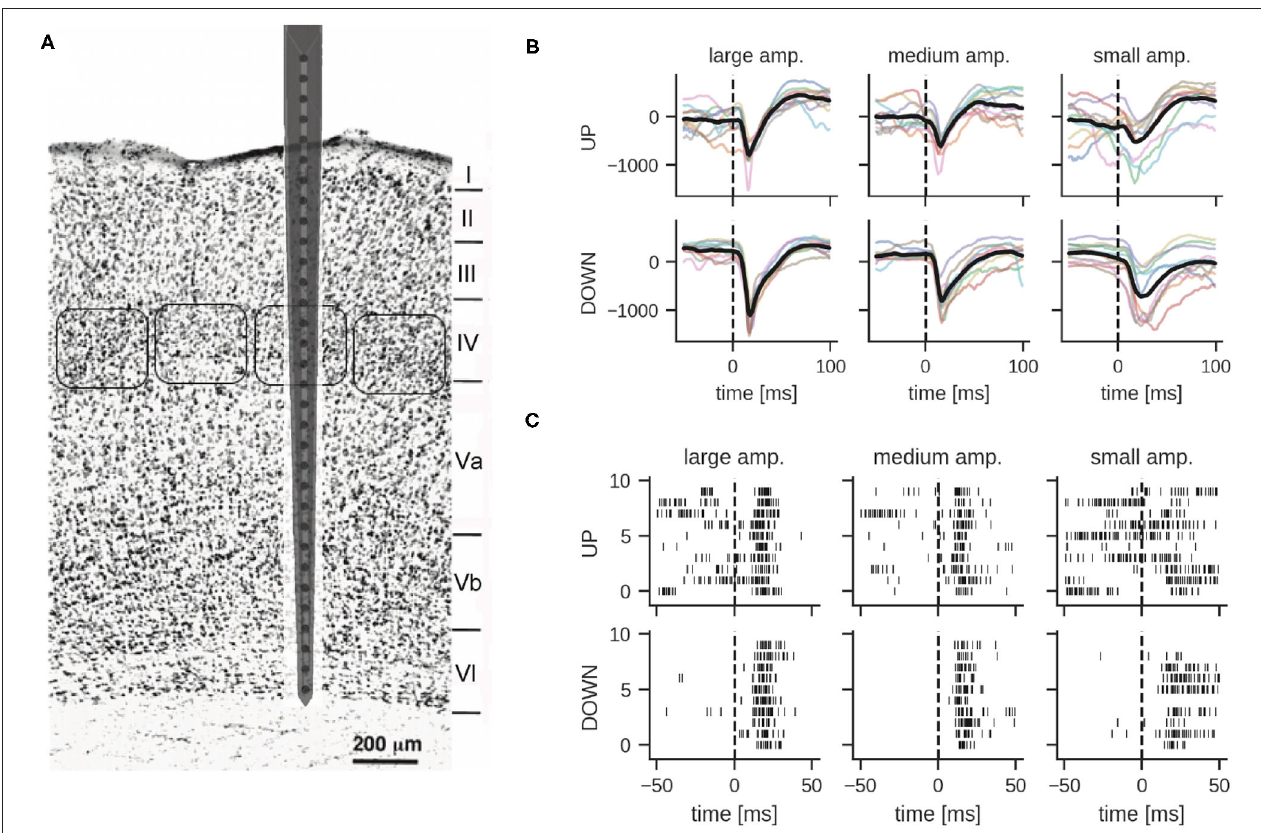
FIGURE 1 | (A) Schematic representation of the neural probe with thirty-two recording microelectrodes implanted in the somatosensory barrel cortex. Twenty-seven out of thirty-two microelectrodes span the six cortical layers, while five recording sites are protruding within the grounded recording solution bathing the brain. Barrel fields at the level of the fourth layer are approximately indicated by rounded boxes. Adapted from Zhang and Deschênes (1997). Copyright 1997 Society for Neuroscience. (B,C) Examples of local field potentials and multi-unit activity in response to whisker stimulation at time 0 (10 trials shown). (B) Comparison of LFP signals from layer IV per stimulation intensity and global network state; different colors correspond to different stimulation trials (units in µ V). The dashed line indicates stimulation onset, the solid thick line shows the mean LFP signal. (C) Multi-unit activity recorded from electrode 18 in layer IV. Each row shows the response to one stimulation of the given amplitude during UP or DOWN